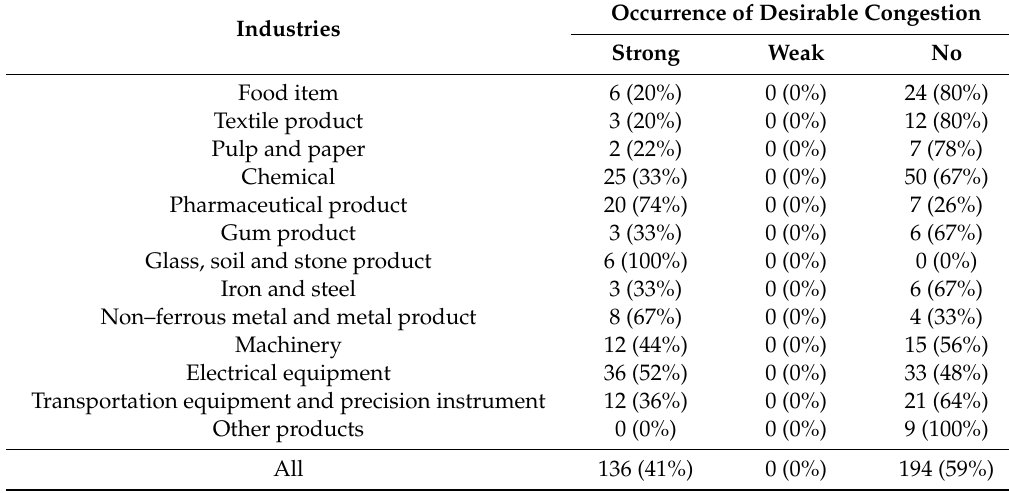
Table 6. Type of desirable